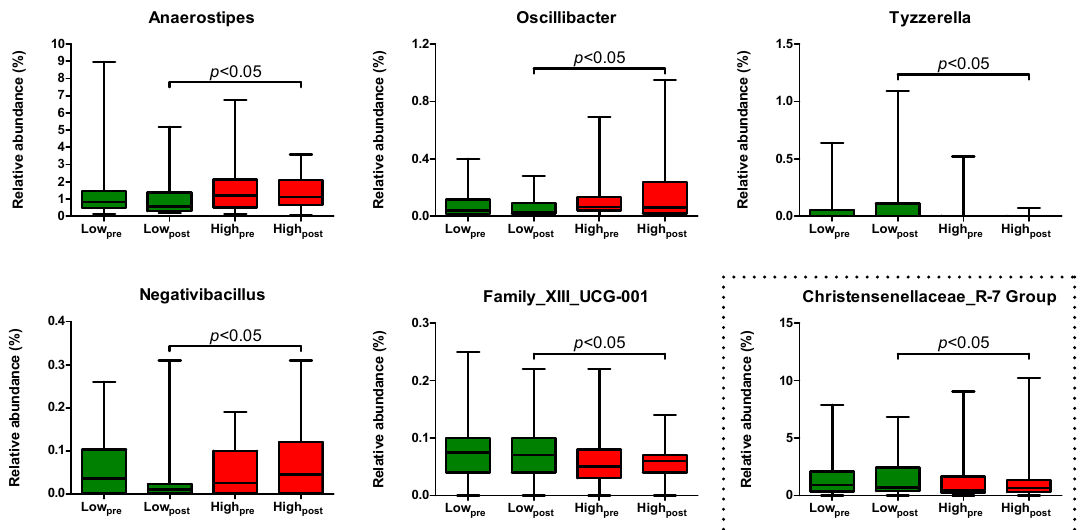
Figure 4. Relative abundance of differentially abundant genera after a 4-week low- (in green) or high-AGE diet (in red) in abdominally obese individuals. n = 34 for the low-AGE group and n = 36 for the high-AGE group. Statistical significance was assessed using beta binomial regression with adjustments for age and sex. Please note that the difference in the relative abundance of the Christensenellaeceae_R-7 Group only became statistically significant after exclusion of a non-compliant participant of the low-AGE group. This participant was included in all other comparisons. All comparisons became statistically non-significant after correction for multiple testing.